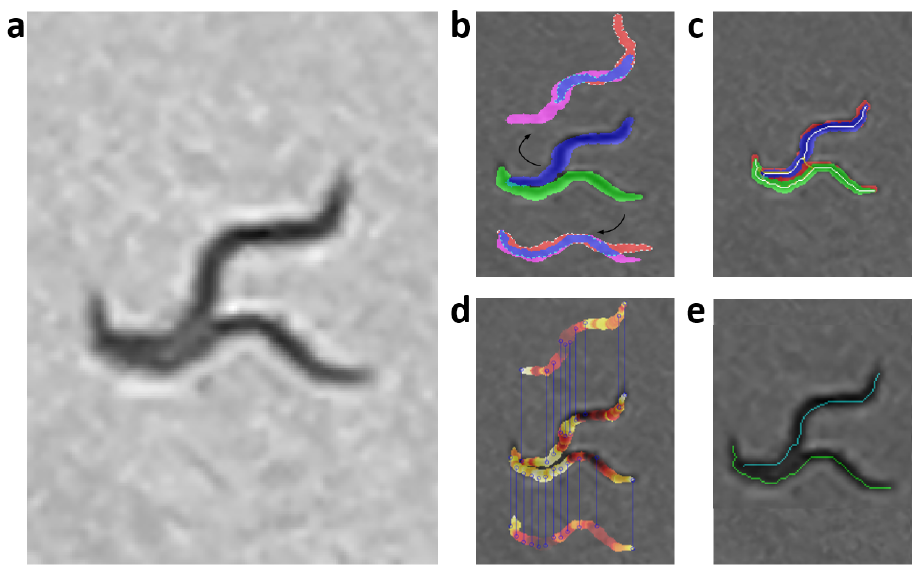
Figure A7. Model 7 evaluation, example 1. The yellow and white pixels are the resulting skeleton using the improved form of skeletonizing. The white pixels are the pixels of the skeleton prediction, which are used to reconstruct the body of each worm (segmentation in blue and green). ( a ) Grayscale image. ( b ) Overlap criterion evaluation. ( c ) Completeness criterion evaluation. ( d ) Color criterion evaluation. ( e ) Optimization result.